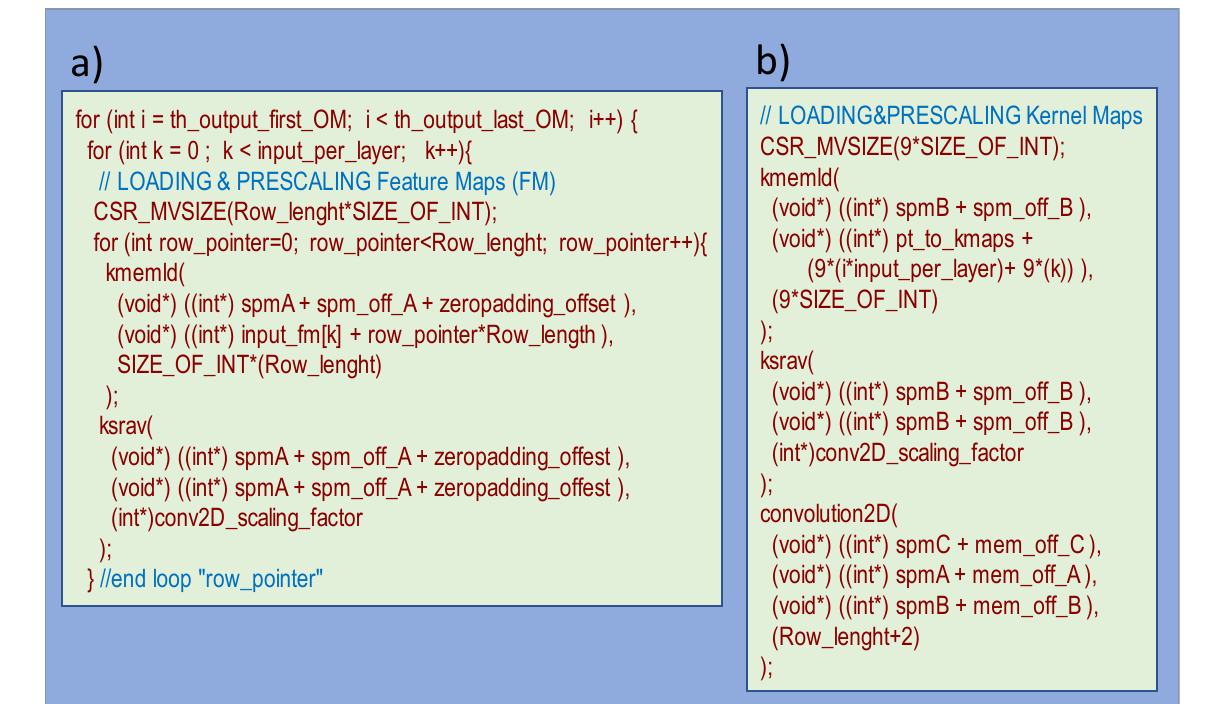
Figure 10. ( a ) Zero-padded, pre-scaled FM setup in SPM; ( b ) Pre-scaled KM collection in SPM and calling sequence of convolution2D() (Layers: 1, 2, 4, 5, 7, 8, 9, 11, 12, 13, 15, 16, 17).